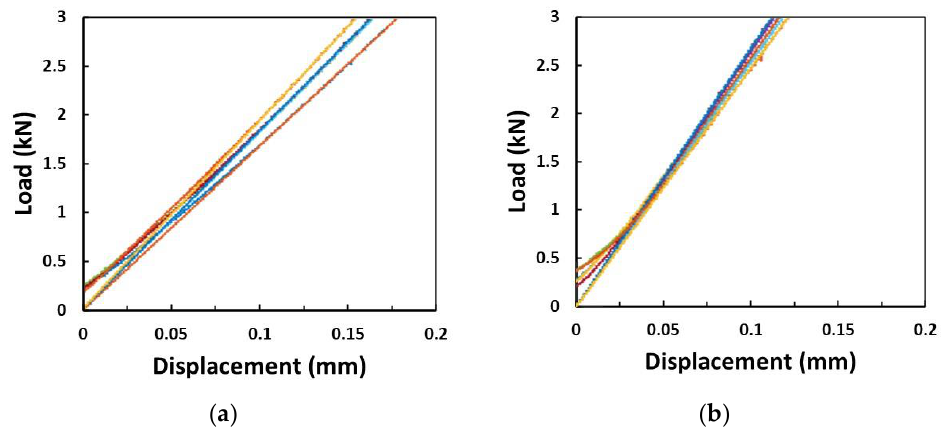
Figure 20. Load vs. Displacement charts for ( a ) specimen DM4 and ( b ) specimen CM3 tested in